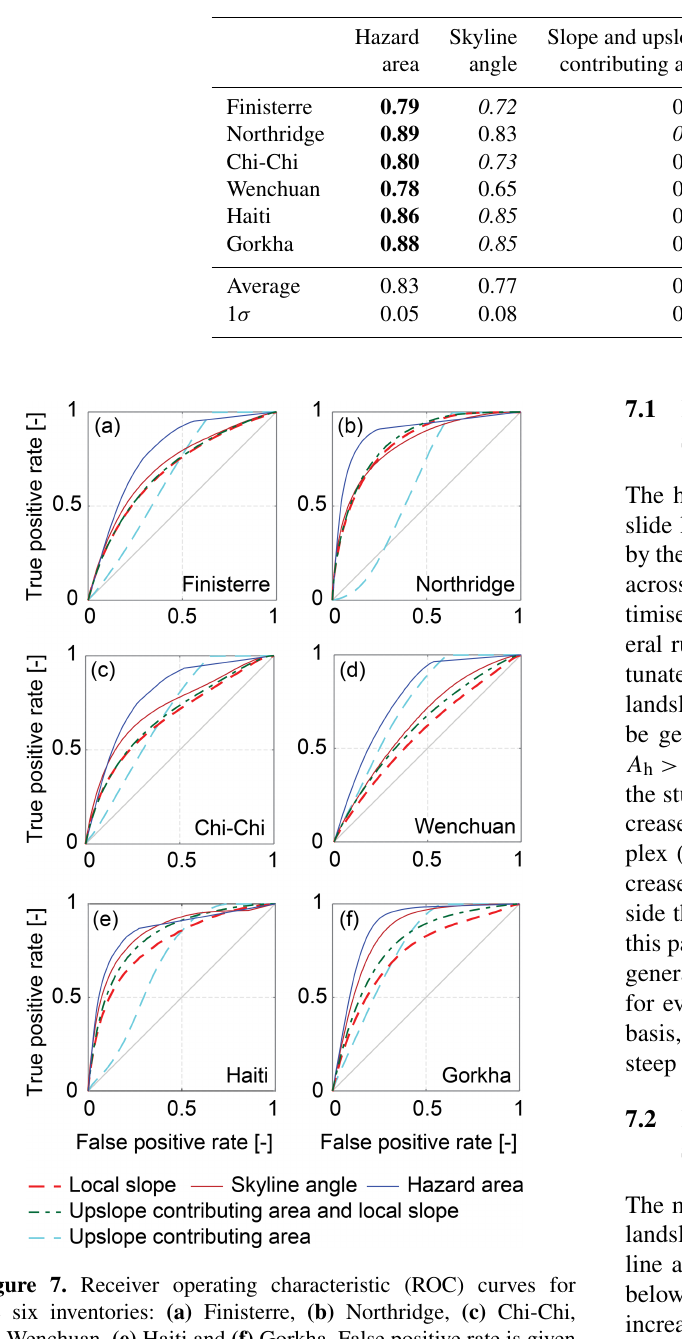
Table 1. Area under the ROC curve for the five hazard metrics over the six coseismic landslide inventories. The best-performing metric for each inventory is in bold, the second best is in italics and the worst-performing metric is underlined.